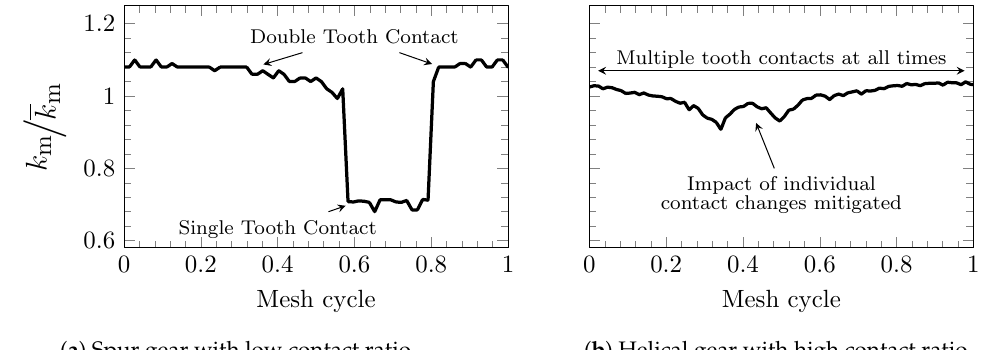
Figure 2. The angle-dependent variation in the mesh stiffness is a significant cause of gear vibration and depends on the specific gear properties, as the comparison for a spur gear, see subplot ( a ), and a helical gear, see subplot ( b ), over one mesh cycle shows. For better comparability, the values are related to the respective average value over one mesh cycle k m . Spur gears generally have a low contact ratio, caused by alternating single and double tooth contact, leading to an abrupt change in the mesh stiffness. Helical gears, in contrast, generally have a high contact ratio due to multiple simultaneous tooth contacts at all times, and thereby an angle-dependent mesh stiffness variation with relative fluctuations of a smaller